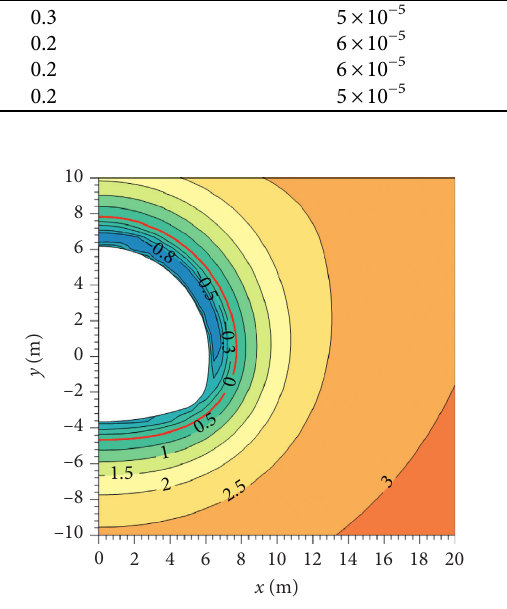
Figure 5: Thermal regimes at D1 in WTIL on April 15 in 5 years of the operation period of the